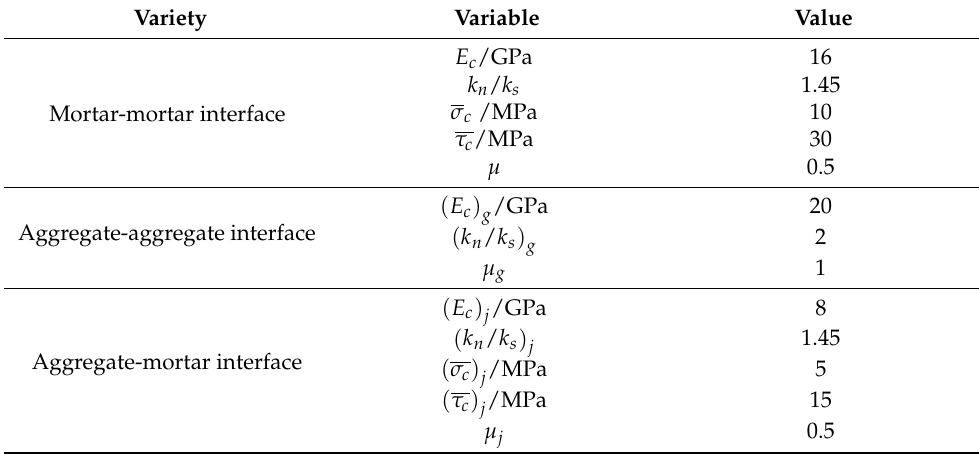
Table 3. Values of microparameters of